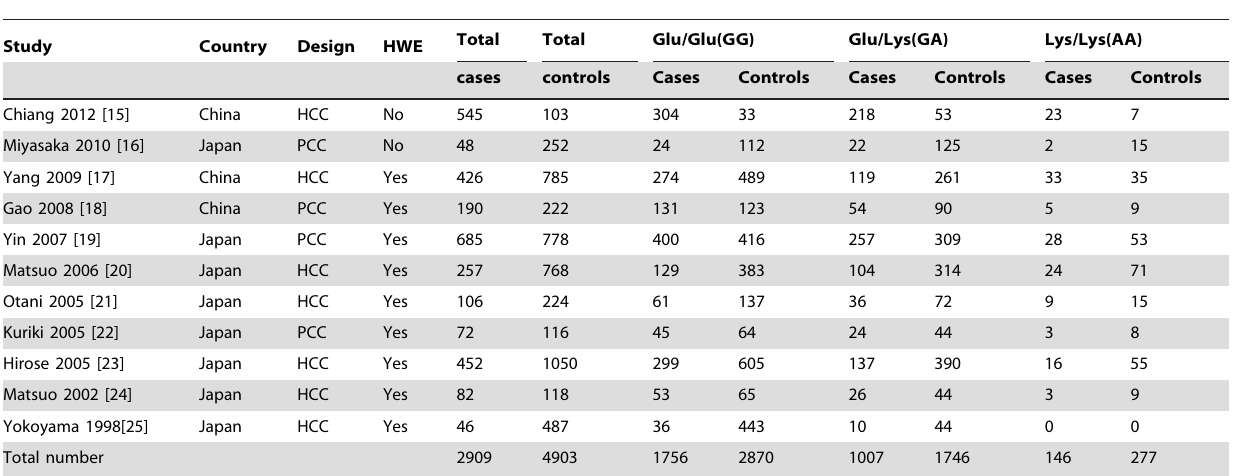
Table 1. Characteristics of studies included in ALDH2 Glu487Lys polymorphism and colorectal cancer.